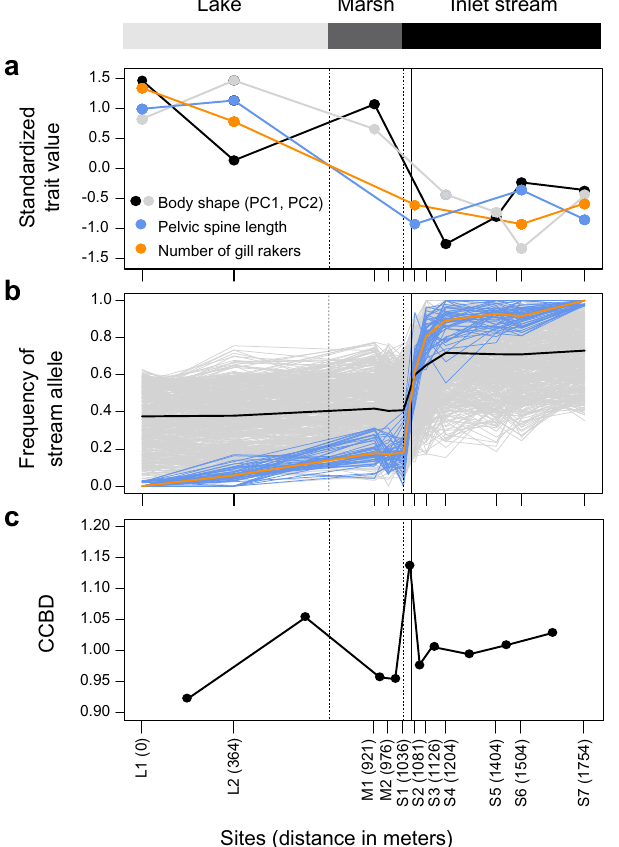
Fig. 2 Phenotypic and genomic differentiation across the lake-stream transition. a Morphology, including geometric morphometric body shape (principal component scores, details in Supplementary Fig. 1), a predator defense trait (pelvic spine length), and a foraging trait (gill raker number). For ease of presentation, only site means are shown. Data were available for a subset of the study sites only. b Frequency of the stream allele at the 50 independent SNPs exhibiting strong differentiation (AFD ≥ 0.97) between the most distant sites L1 and S7 (i.e. the selected SNPs, blue lines; their median frequency is shown in orange), and at 500 neutral SNPs (gray lines; median frequency in black). Source data are provided as a Source Data fi le. c Chromosome center-biased differentiation (CCBD), calculated for all pairs of neighboring samples. The midpoint between the paired samples is used as location along the gradient. In all panels, the dotted vertical lines indicate the lake-marsh and marsh-stream habitat boundaries and the black vertical line indicates the cline center estimated for the selected and neutral SNPs (1071 m). The distances on the X -axis represent the approximate swimming distance between each site and the lake site L1.